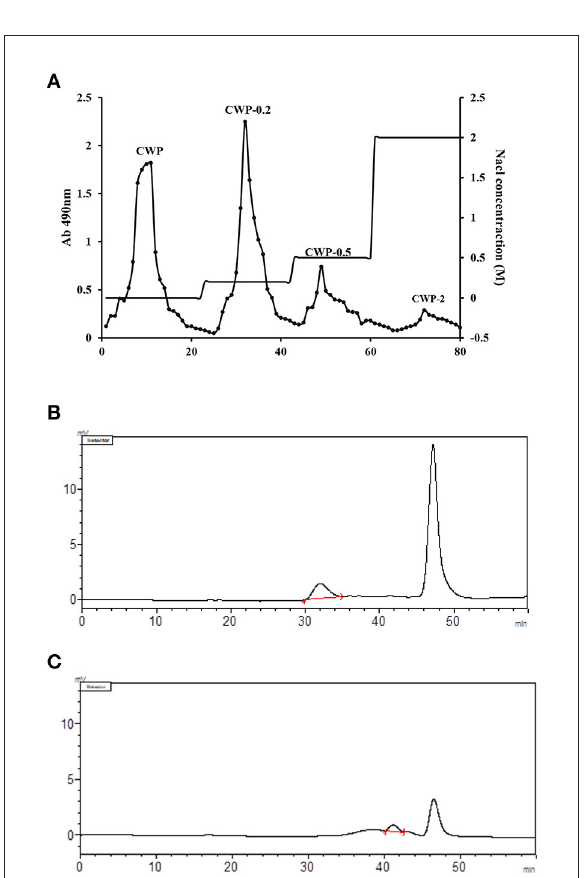
FIGURE1 (A) Elution curve of chickpea polysaccharide on a DEAE Sepharose Fast Flow column. The crude polysaccharide was dissolved in distilled water and applied to the column, with elution with distilled water and NaCl (0.0–2.0M). The eluent solution was collected and the carbohydrate content of the collected fraction was monitored using the phenol-sulfuric acid method. GPC chromatogram of (B) CWP and (C) CWP-0.2 for molecular weight determination with the size exclusion method Chromatography